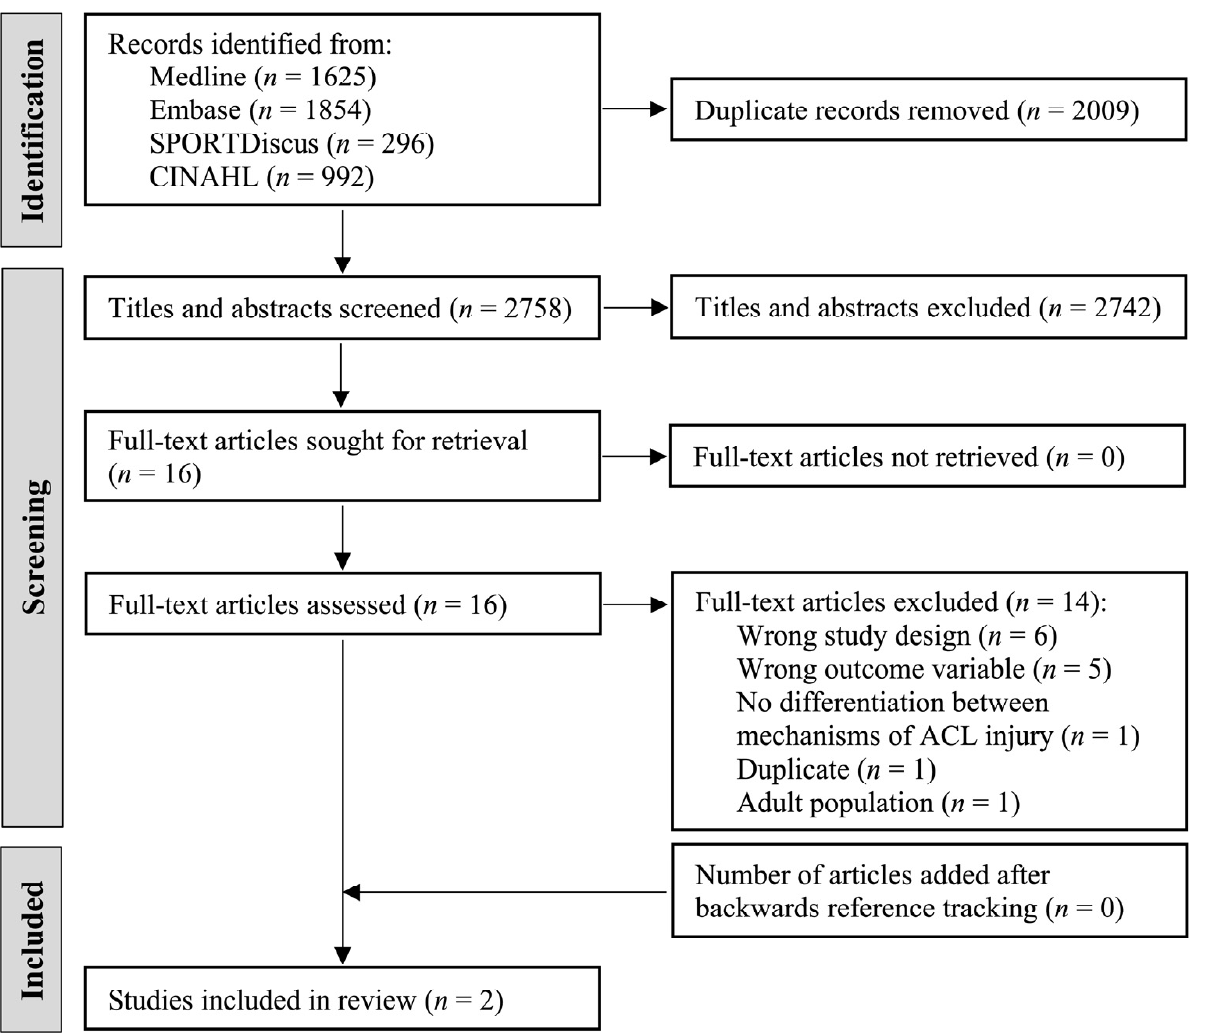
Figure 2. PRISMA flow diagram of the literature search for primary articles.